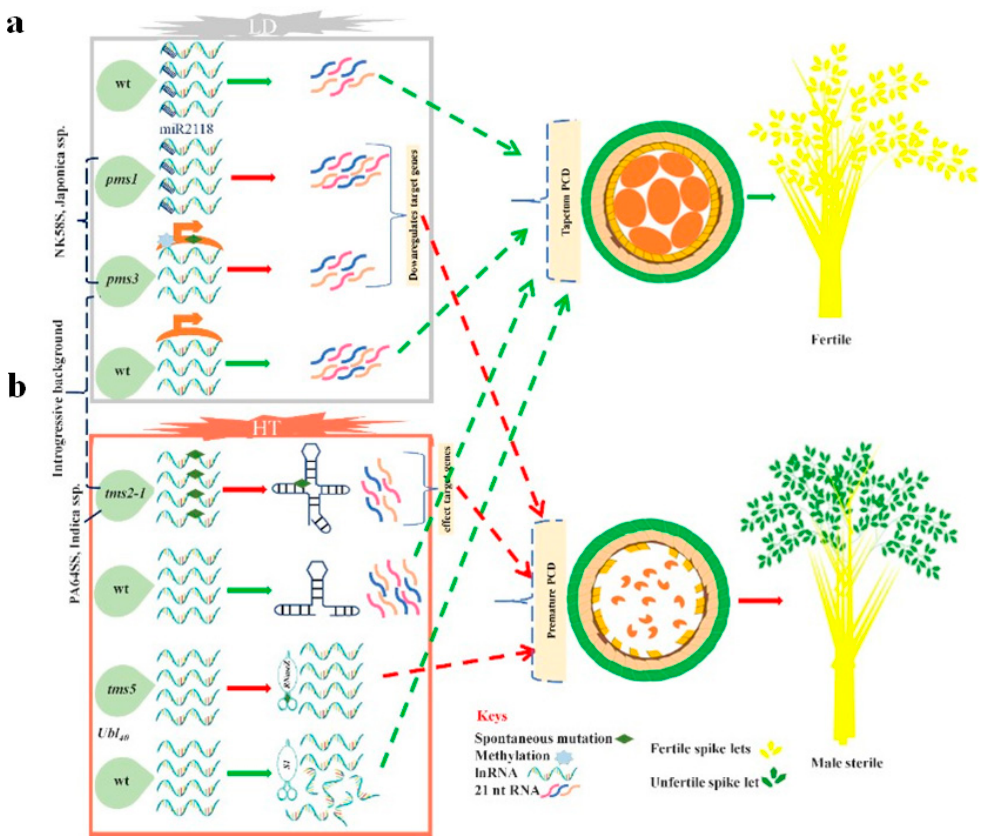
Figure 4. Regulation of the male fertility of EGMS-lines in two-line HR through photoperiod and temperature alterations. (a) The NK58s (Japonica genetic background) comprise the single nucleotide polymorphism (SNP) within two long-noncoding RNAs (lncRNAs), pms1 and pms3. The SNP in